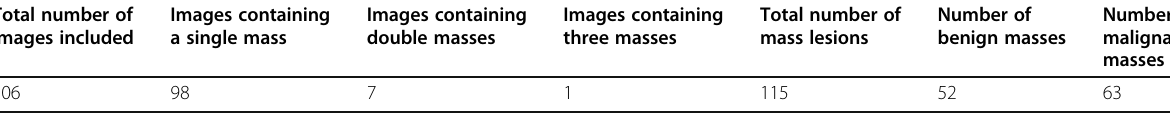
Table 1 Detailed description of mammographic image dataset [22] Total number of Images containing images included a single mass